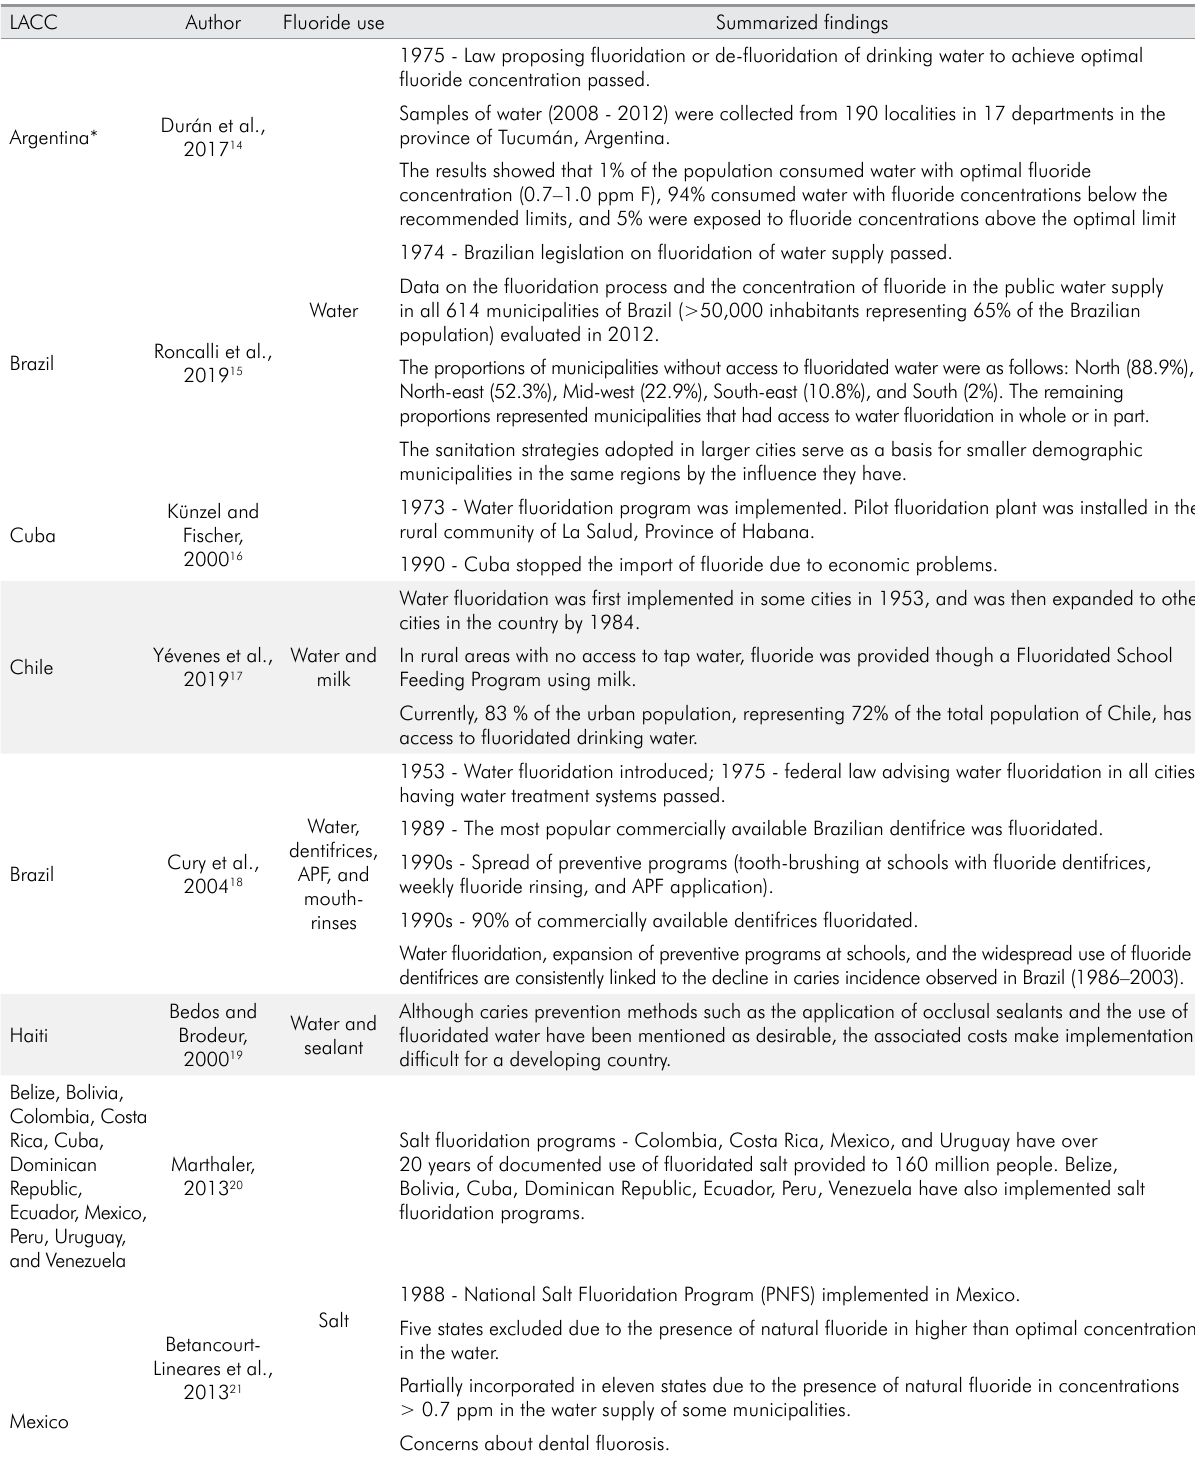
Table 2. Fluoride use for dental caries control in Latin American and Caribbean countries